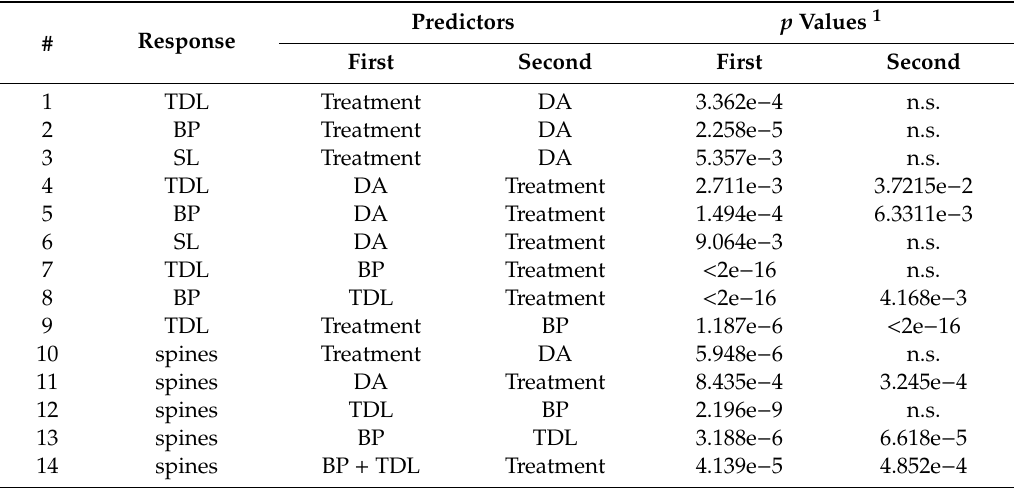
Table 2. Analyses of MSN morphology at 21 days by linear